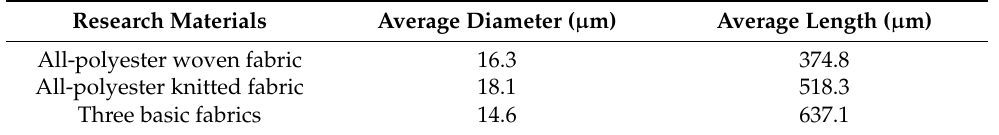
Table 11. Average diameter and average length of